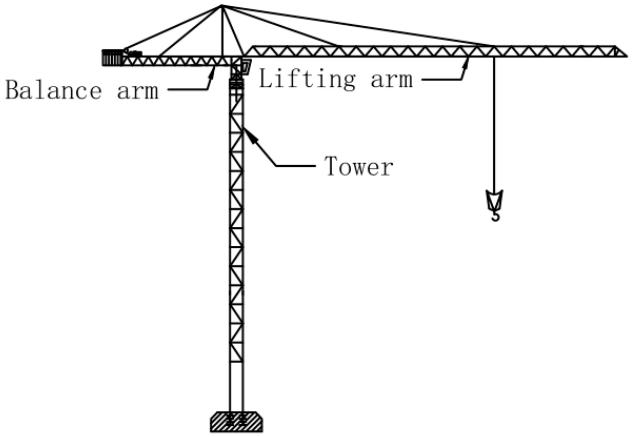
Figure 1. Structure diagram of attached tower crane (part).